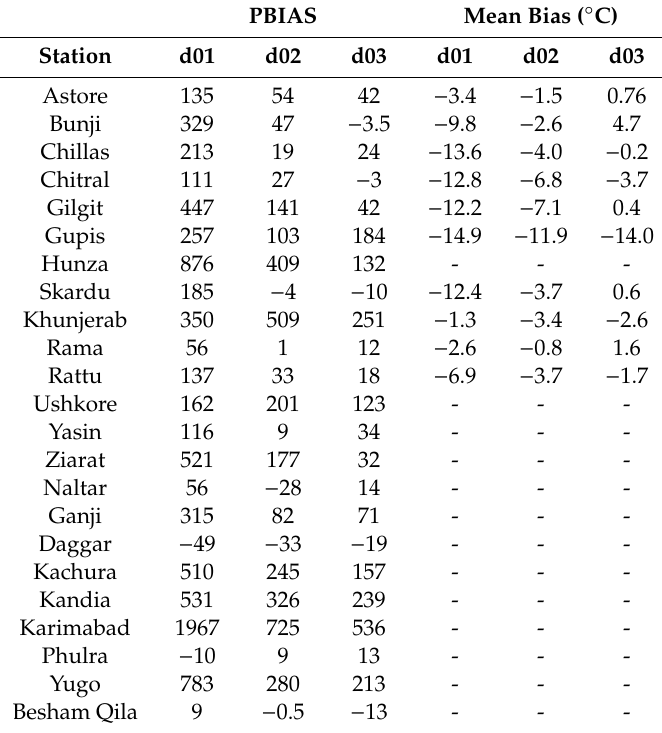
Table 4. PBIAS of precipitation and mean bias ( ◦ C) of T2 after lapse rate correction between WRF and stations in d01, d02, and d03 at an annual time